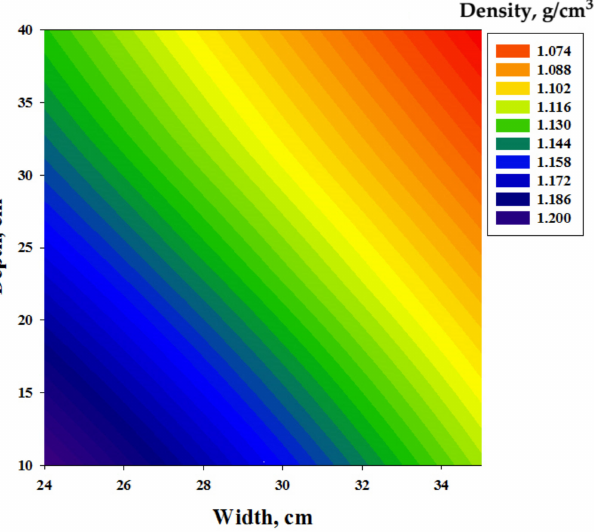
Figure 10. Binary effect of tire type and soil depth on the soil bulk density.